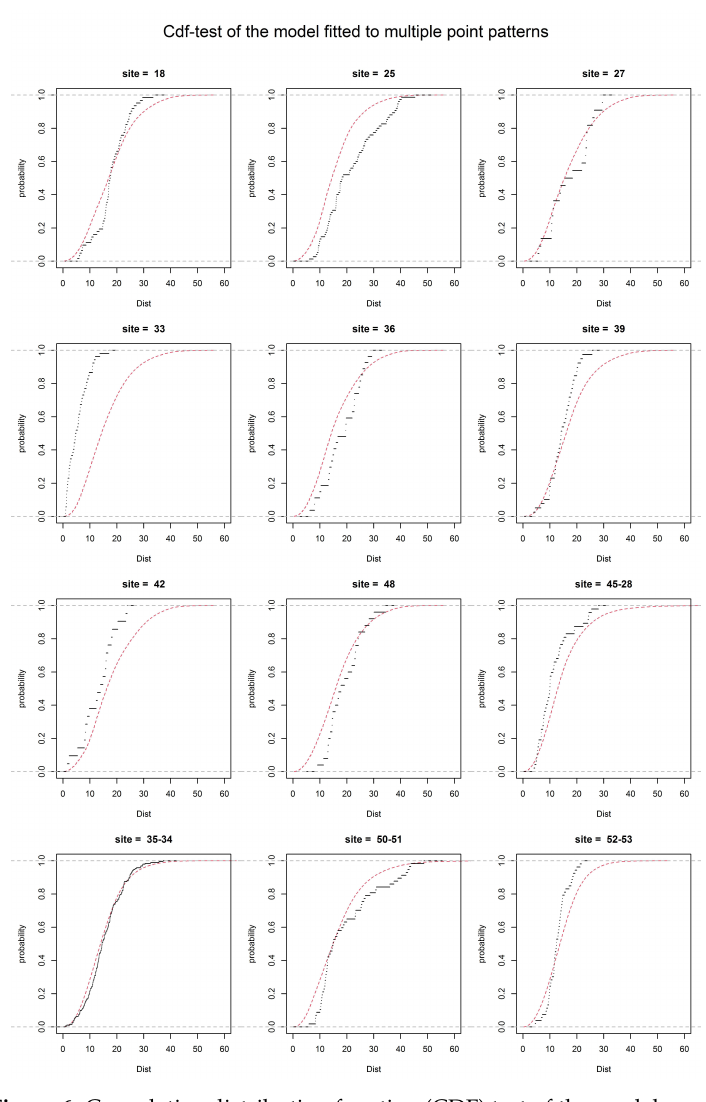
Figure 6. Cumulative distribution function (CDF) test of the model; covariate is the distance to the next source and the overall p -value = 0.503. The red dotted line represents the model whereas the grey dotted line gives measured values.